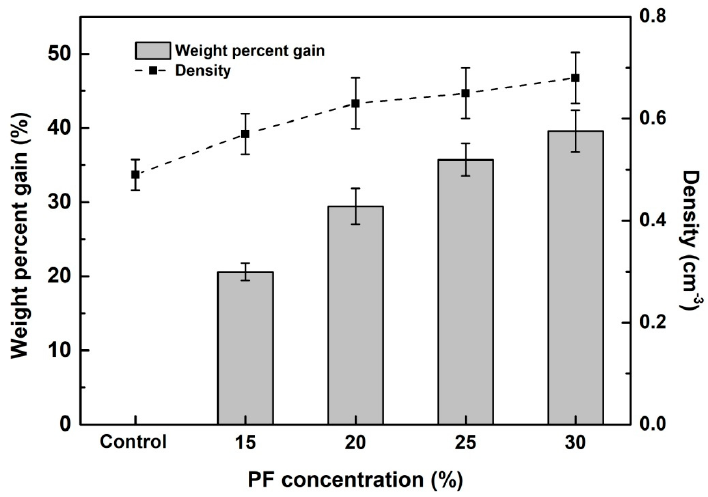
Figure 2. Weight percent gain (WPG) and density of the control and modified wood. PF = phenol formaldehyde.